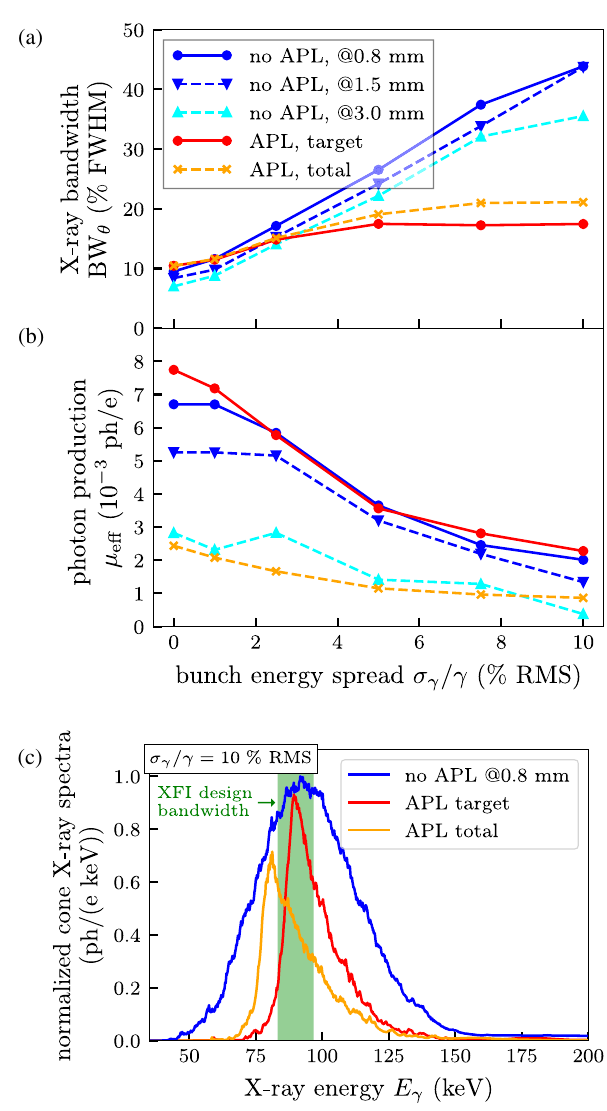
FIG. 2. APL-focusing setup. The transverse RMS bunch size σ x is plotted as a function of the propagation distance after the plasma target at z ¼ 0 . Free drift is shown as green, the APL as red shaded area. The inset displays the single electron trajectories in the focal region for an electron bunch of 10%RMS energy spread. Electrons at target energy are colored green, lower (higher) energies in blue (red).